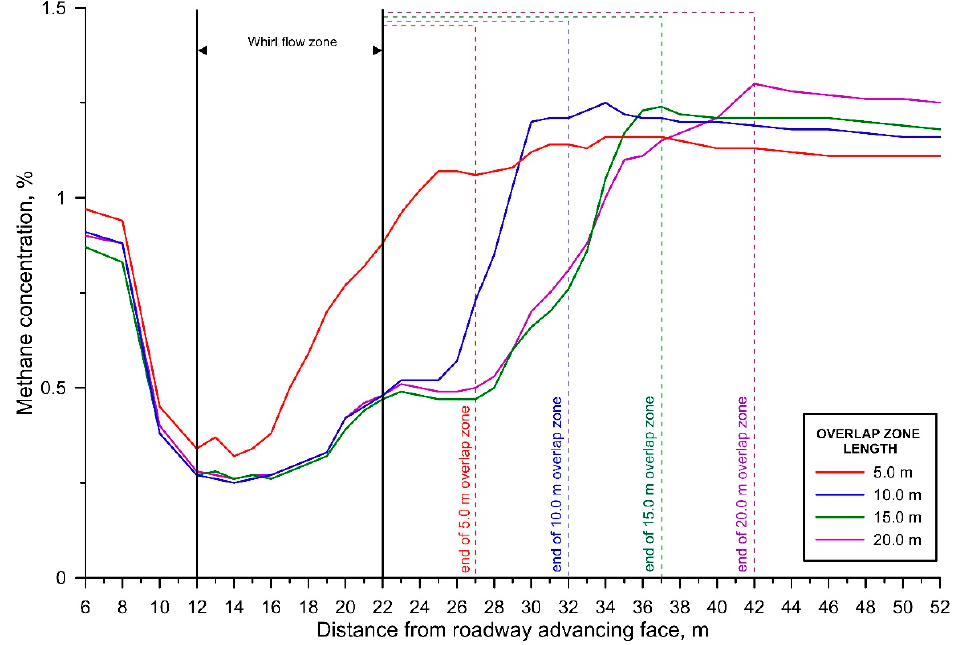
Figure 15. Mean methane concentration within the roadway in function of the distance to the face.